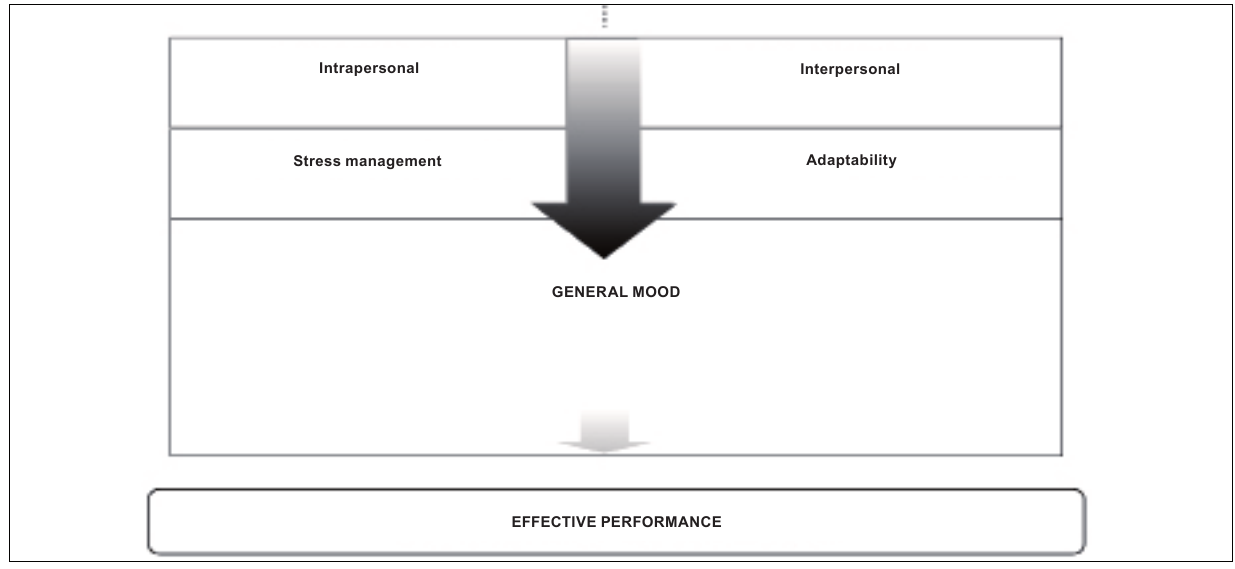
FIGURE 3 Effective performance model (Sipsma,